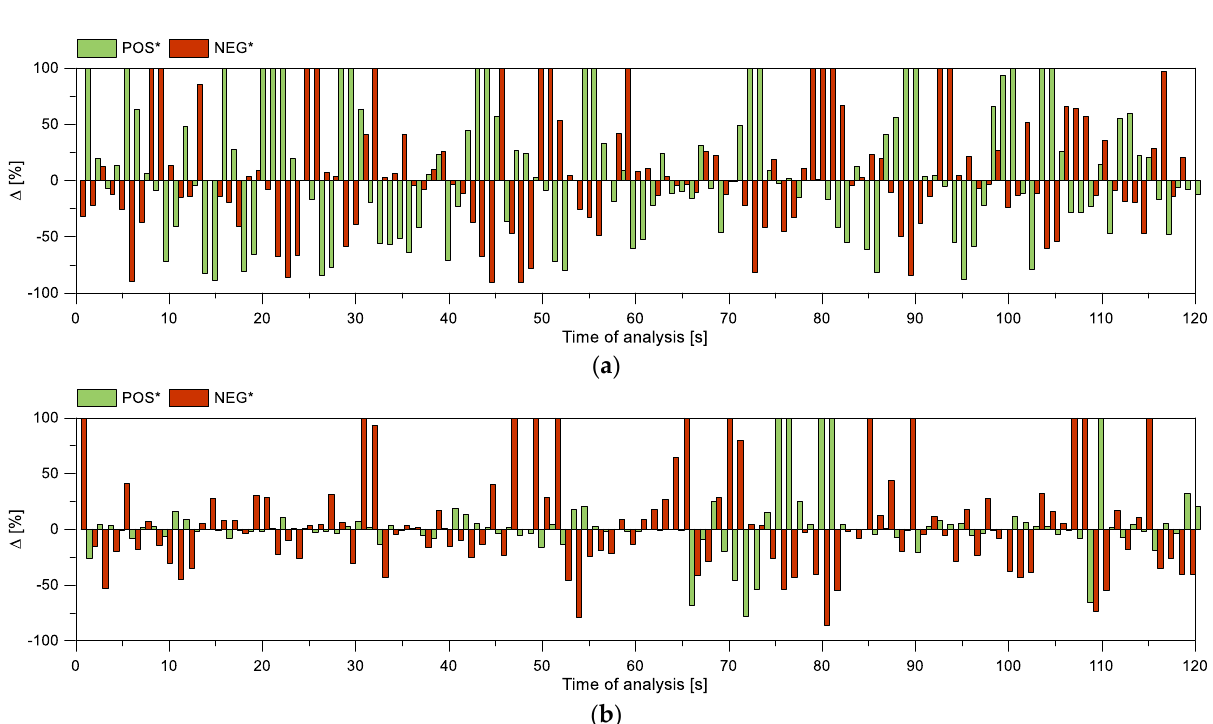
Figure 11. Examples of POS and NEG variation over the time of analysis, for a single participant exposed to ( a ) static and ( b ) dynamic VR stimuli.